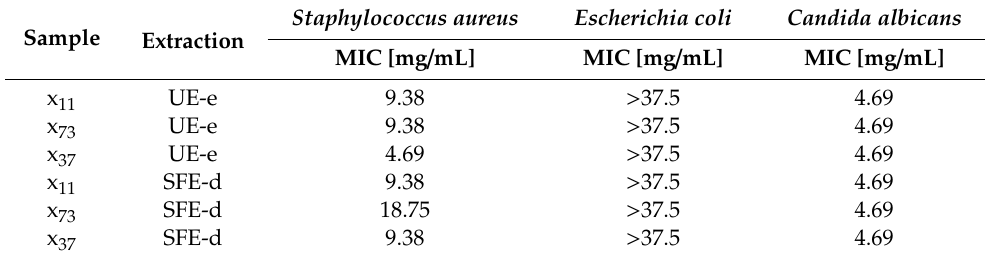
Table 3. Minimum inhibitory concentration MIC [mg/mL] of six different ginger-industrial hemp extracts.